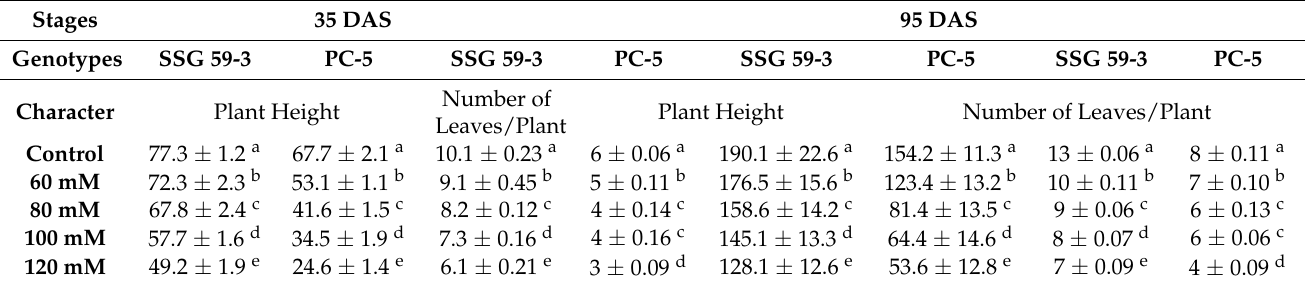
Table 4. Yield attributing traits in sorghum under salt